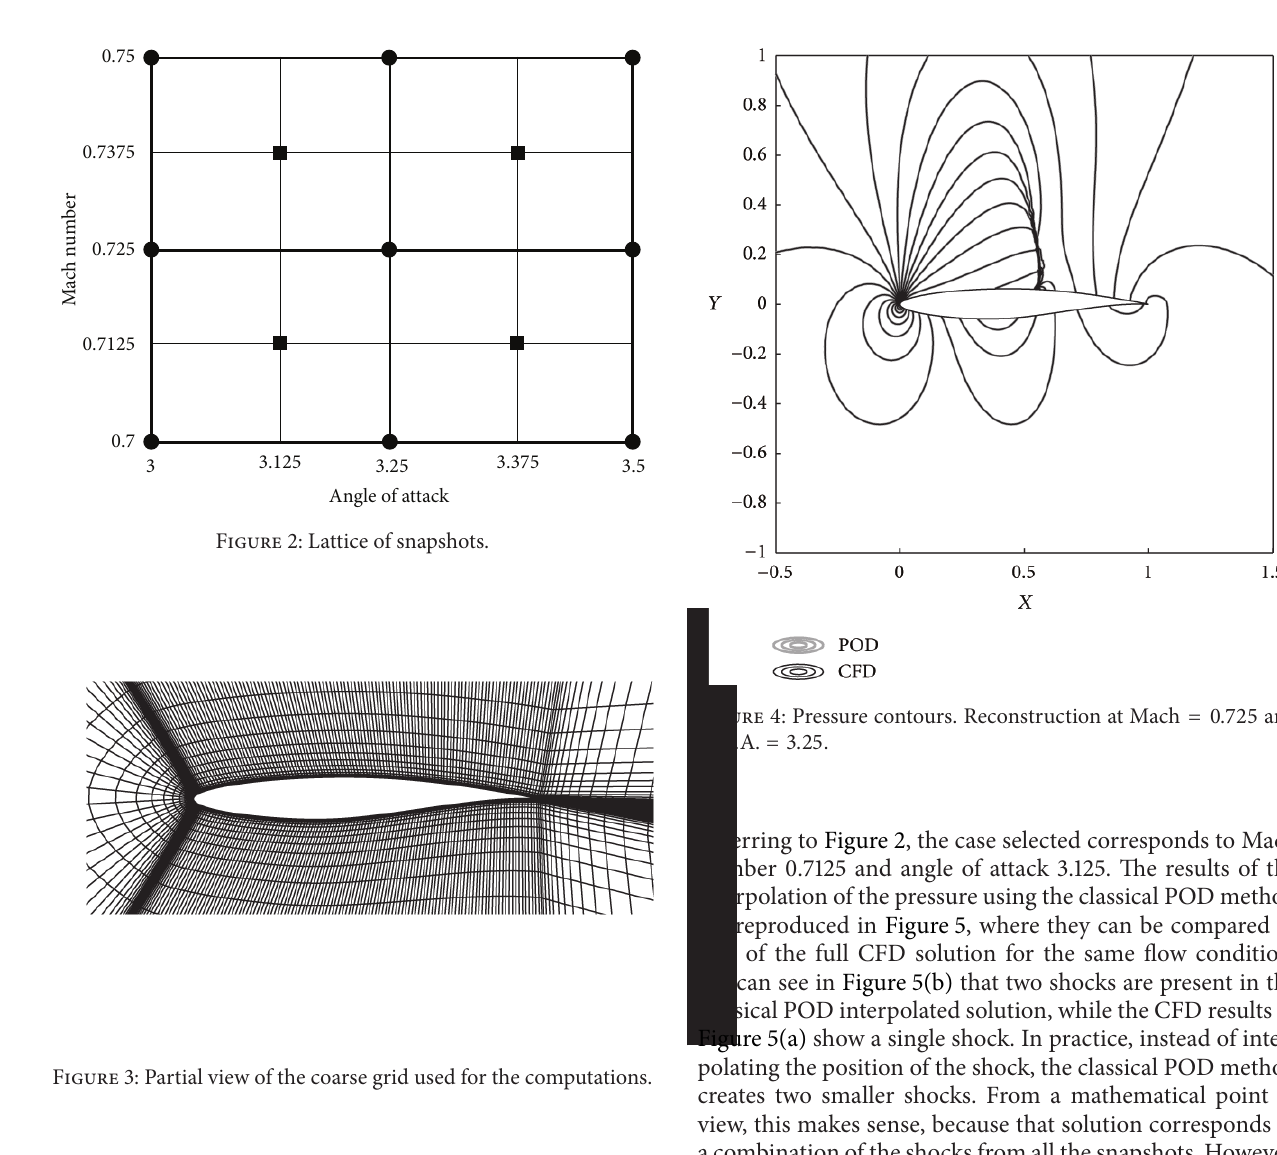
selected, and second order upwind resolution associated with the Green-Gauss cell center algorithm was used. Boundary